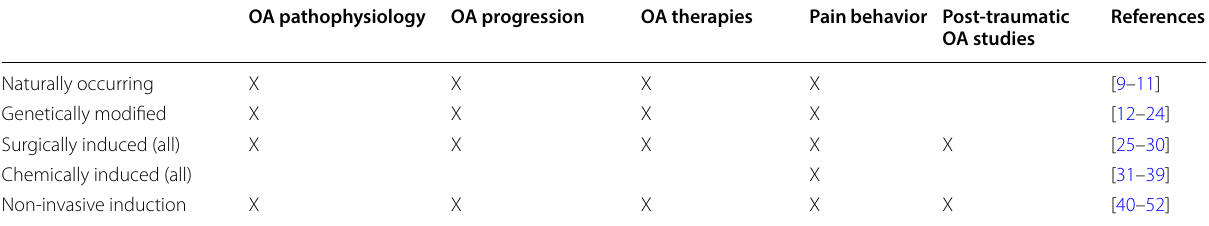
Table 2 This table indicates the appropriate uses for each type of murine OA model. An X indicates that a model is appropriate for a specific type of